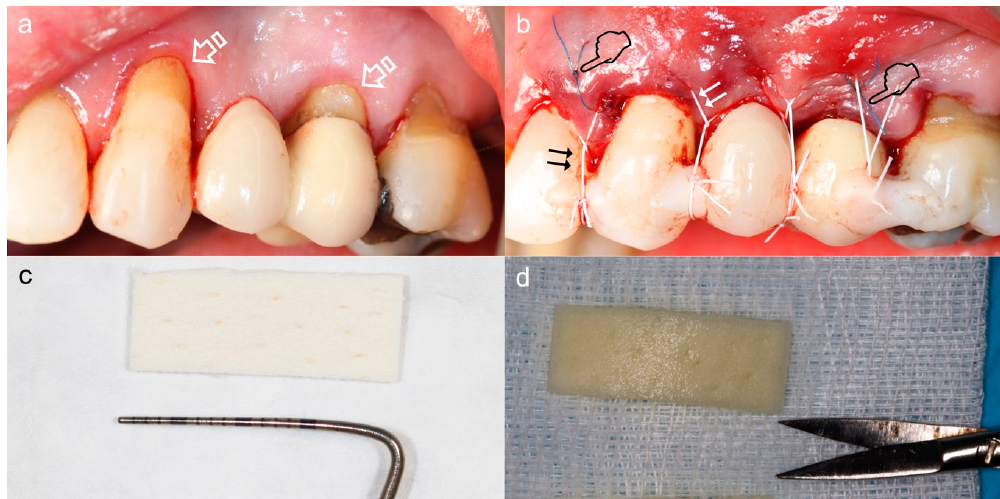
Figure 6. Soft tissue augmentation in an implants’ second stage surgery using Mucograft. ( a ) Prior surgery ( b ) Post-surgery with the matrix fixed to the recipient bed ( c ) 2 weeks follow-up ( d ) 3 months follow-up. This matrix was used as contouring of soft tissue around dental implants. The reduced ridge (pointer in ( a )) was thickened after soft tissue augmentation (pointer in ( d )). Mucoderm (botiss gmbh, Berlin, Germany) is a porcine-derived acellular dermal matrix (PADM) obtained by eliminating the antigenic constituents using a multi-step procedure, which enhances the preservation of the whole extracellular collagenous matrix [4]. This matrix can serve as a three- dimensional scaffold to facilitate fibroblasts and endothelial cells proliferation, leading to fast revascularization [25] (Figure 7).